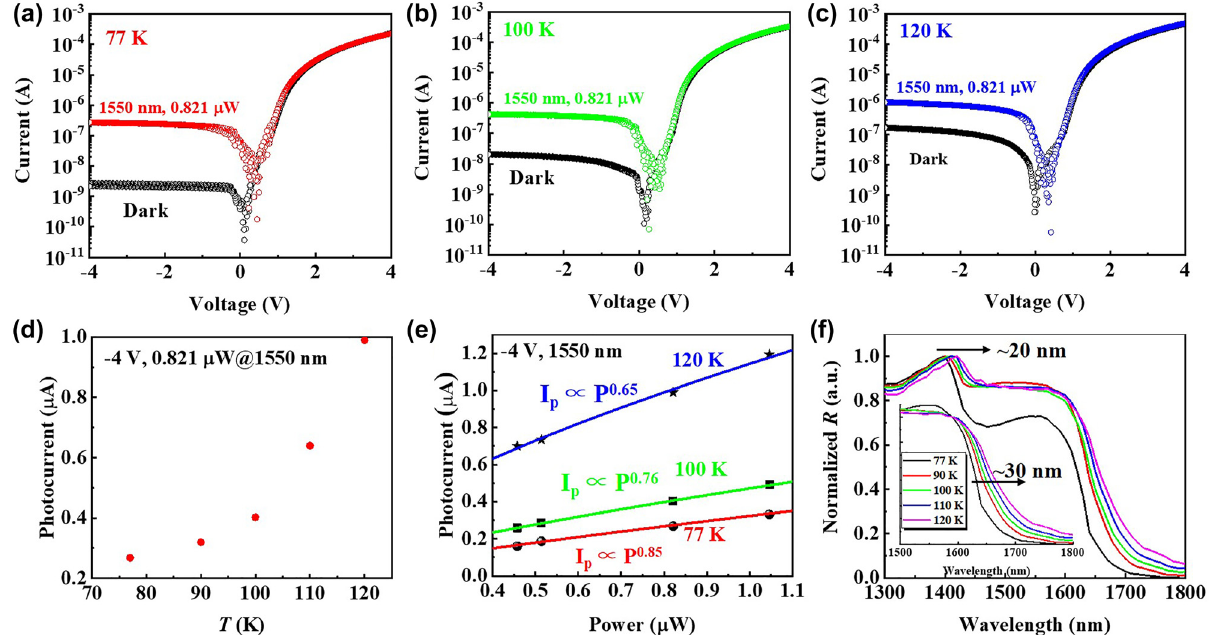
Figure 6: I – V curves of the GeSn NW PD under dark and illumination of 1550 nm light with a power of 0.821 μ W at (a) 77 K, (b) 100 K, and (c) 120 K. (d) Photocurrent of the GeSn NW PD under illumination of 1550 nm light with a power of 0.821 μ W under − 4 V bias as a function of temperature. (e) Dependence of photocurrent of the GeSn NW PD under 1550 nm light illumination on incident light power under − 4 V at 77 K, 100 K and 120 K. (f) Normalized response spectra of the GeSn NW PD based on Ge absorption edge and GeSn absorption edge (inset) under − 4 V at 77 K–120